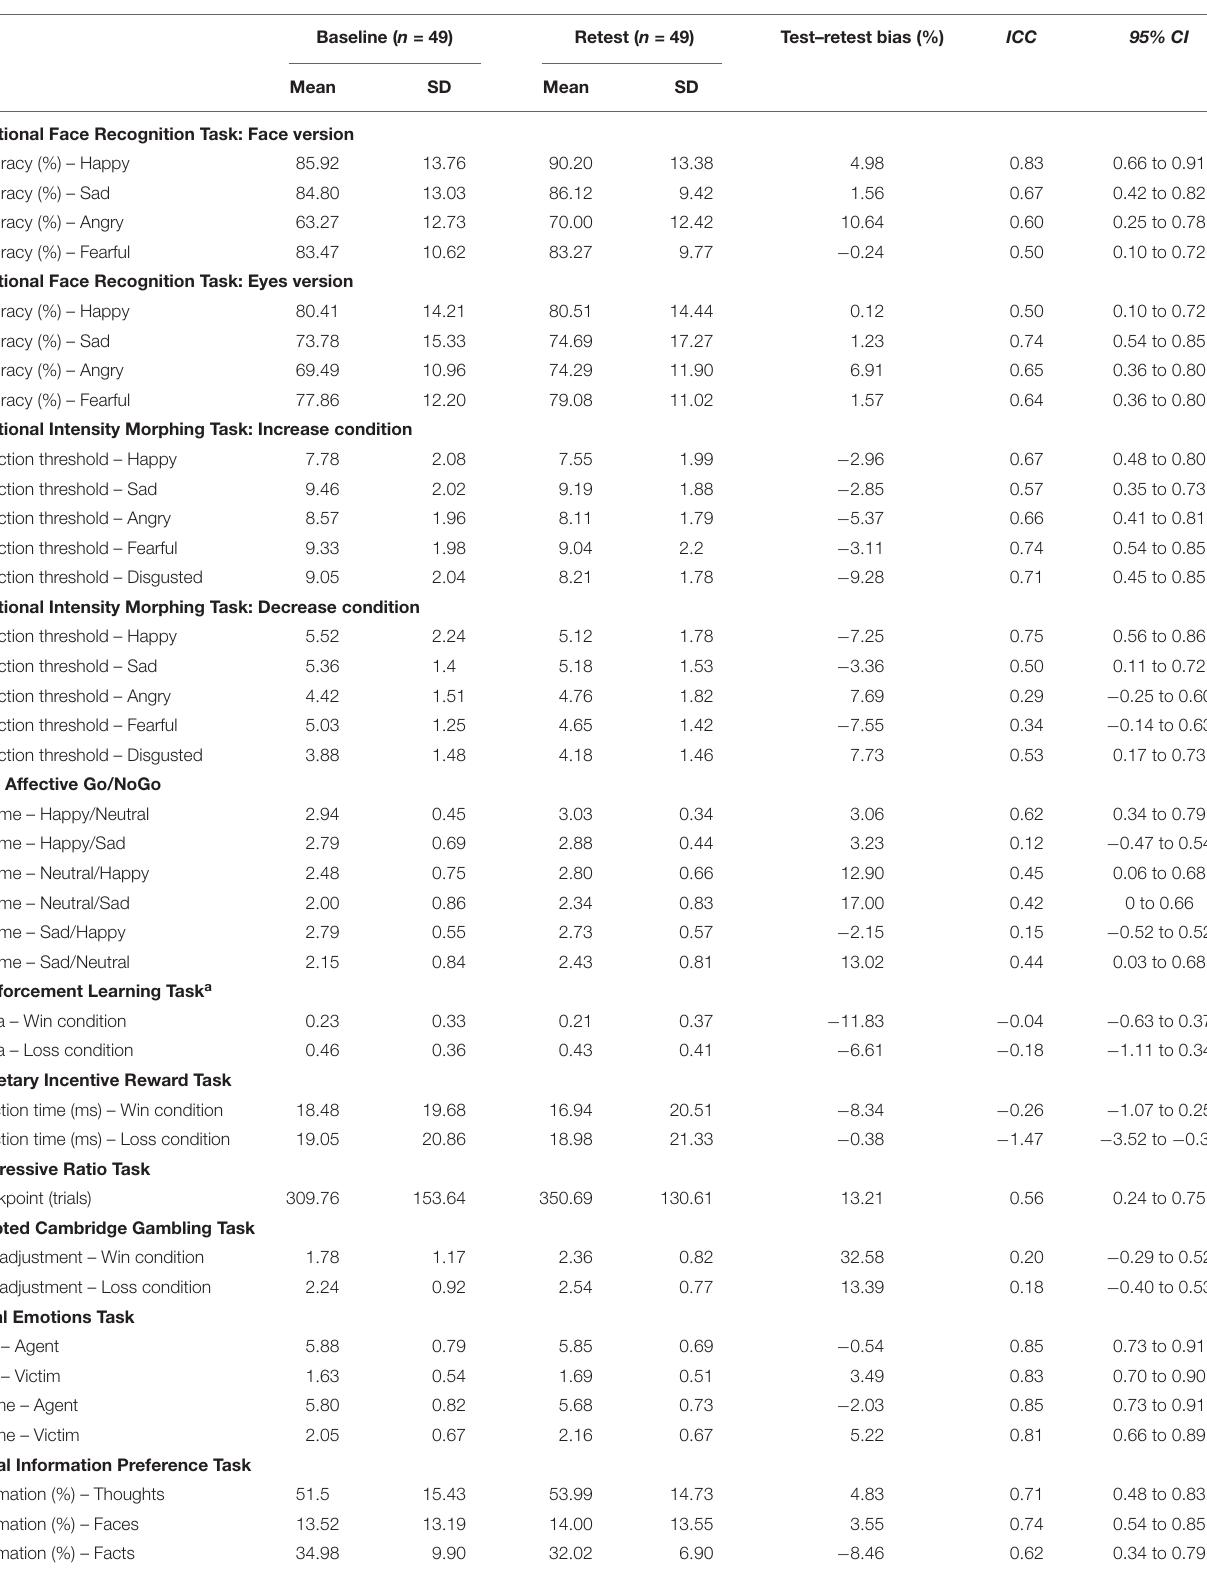
TABLE 4 | Test–retest